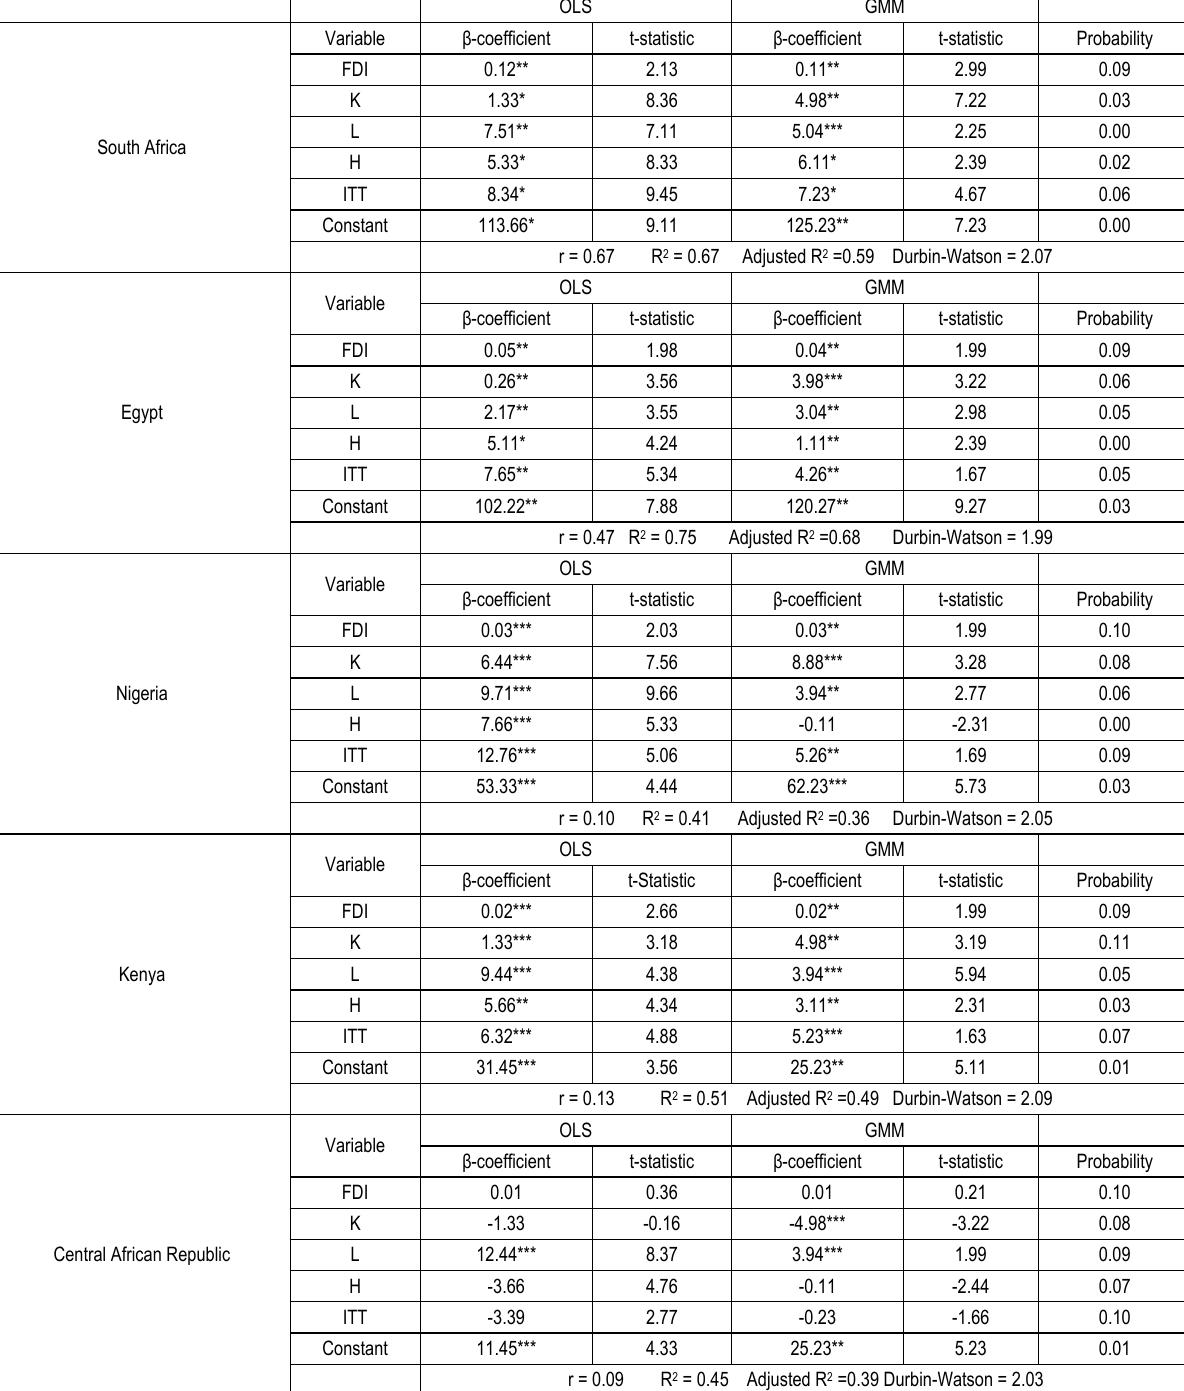
Table 2. OLS and GMM estimation regression results for FDI inflow OLS GMM